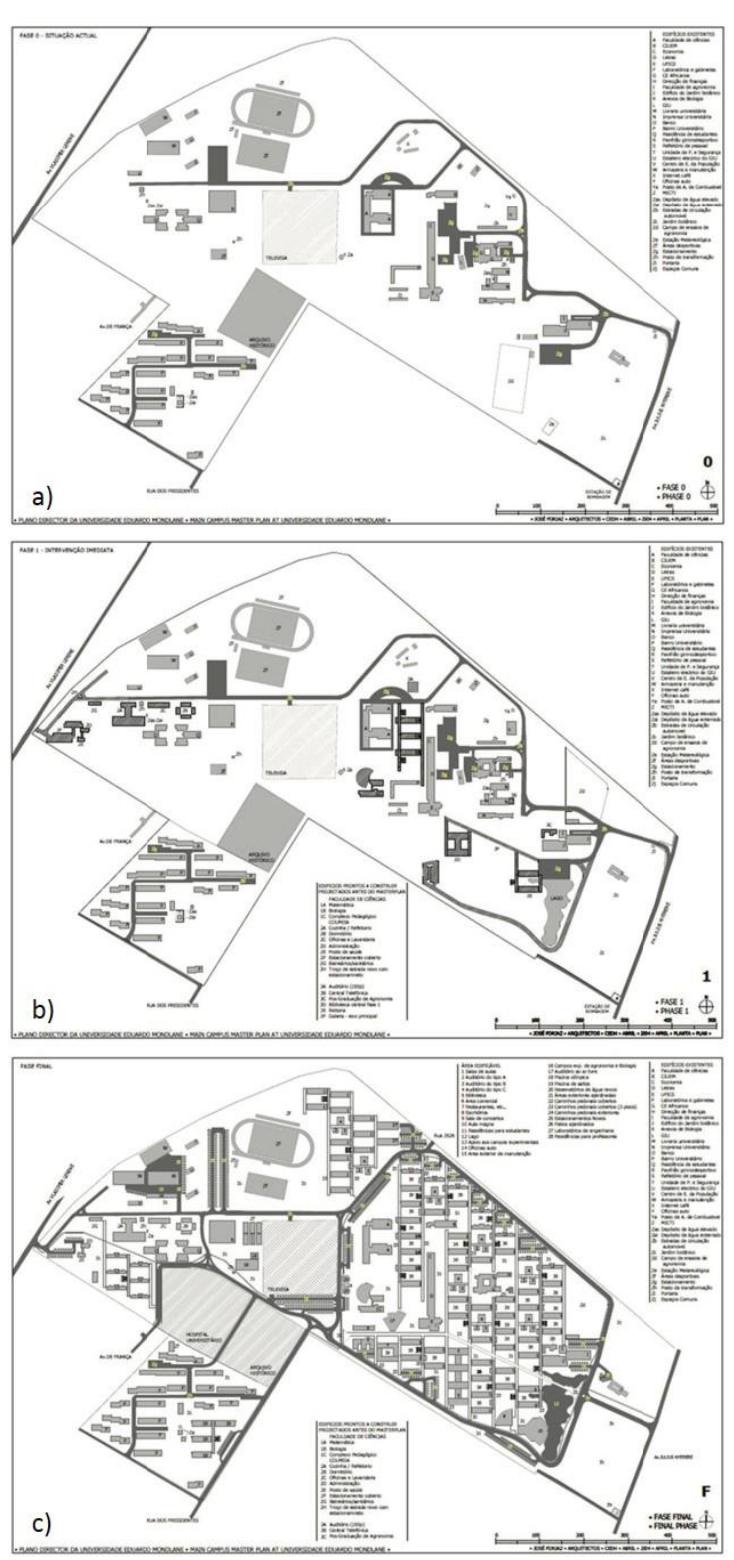
Figure 2. The Campus in 2004. ( a ) starting situation (phase 0): the Campus in 2004, ( b ) the interventions deemed immediate by the Forjaz’s Plan (phase 1), ( c ) Forjaz’s Masterplan for 2006–2020 (final phase).